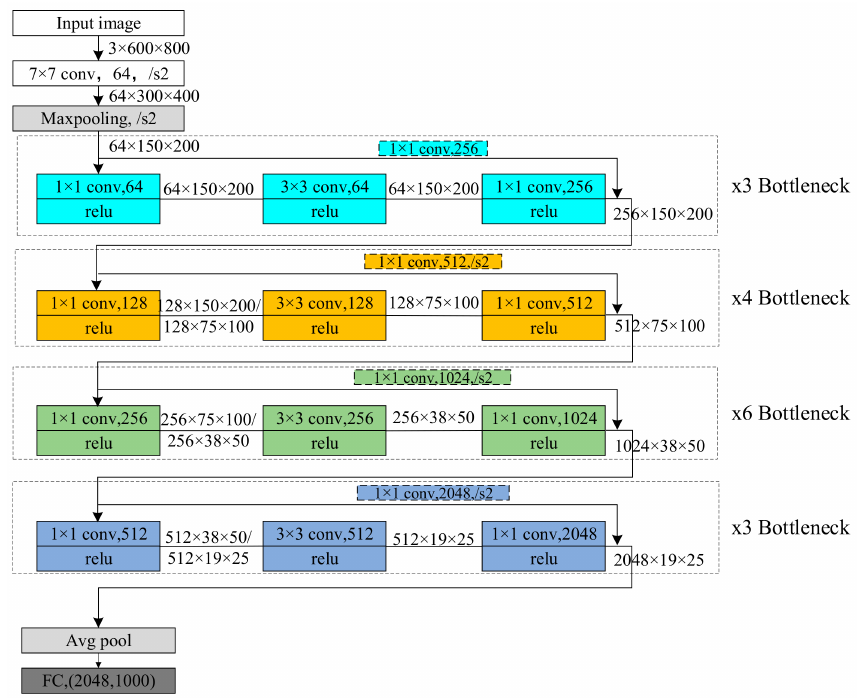
Figure 6. Architecture of the ResNet-50 residual neural